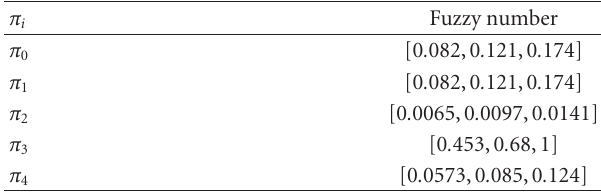
Table 13: Fuzzy steady state probabilities.